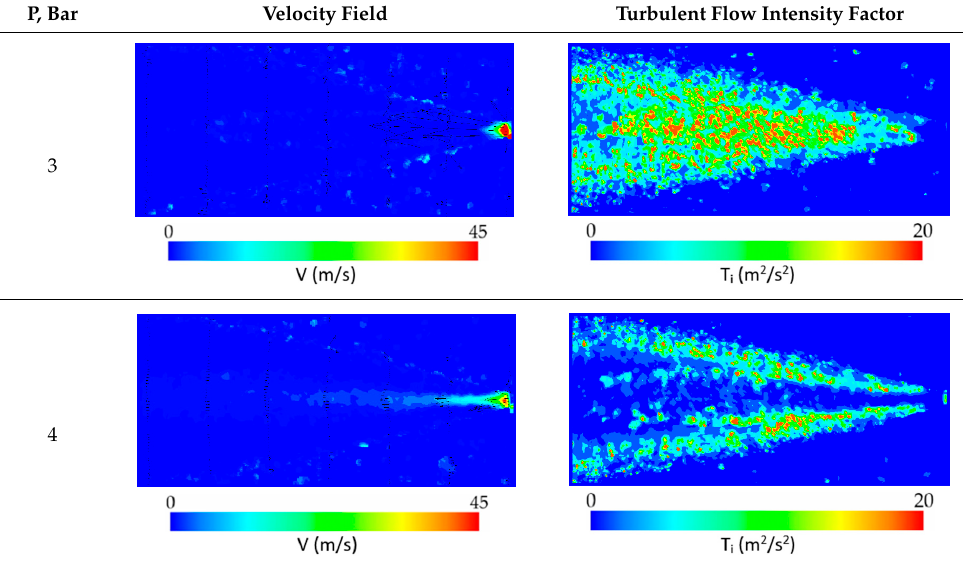
Table 2. Influence of pressure P supplying the nozzle on the character of velocity and turbulent flow intensity factor fields for stub regulation angle α = − 90°.